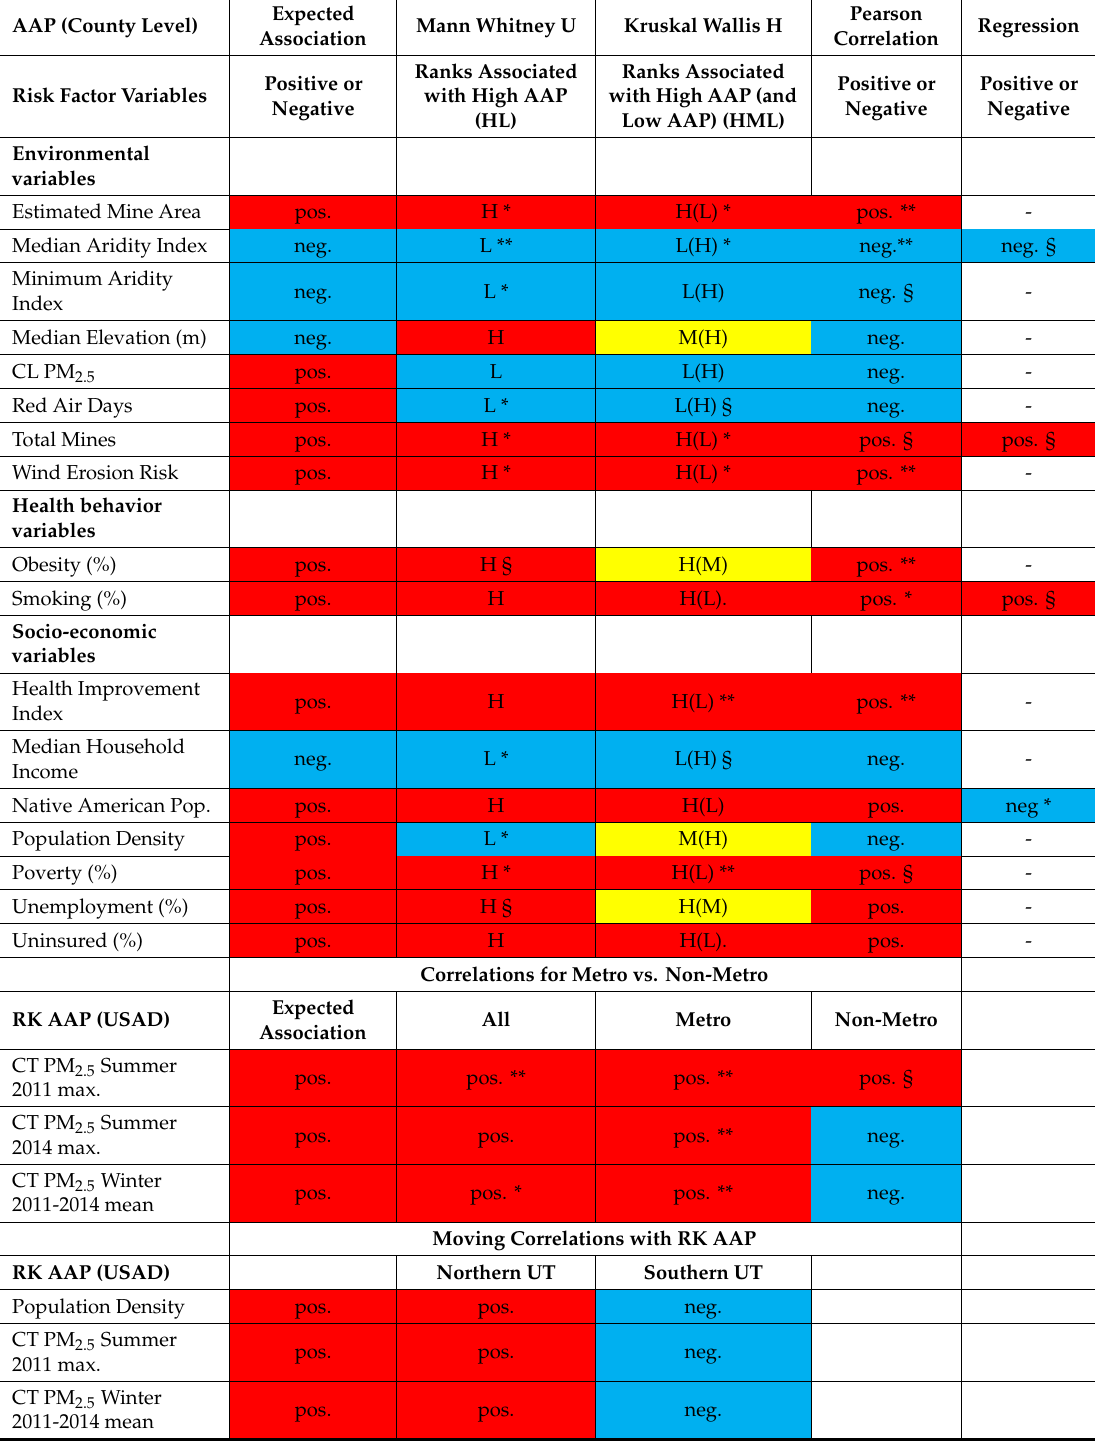
Table 7. Summary of all associations between risk factors and AAP found in statistical analysis (Red indicates positive association, blue indicates negative association, yellow indicates changing